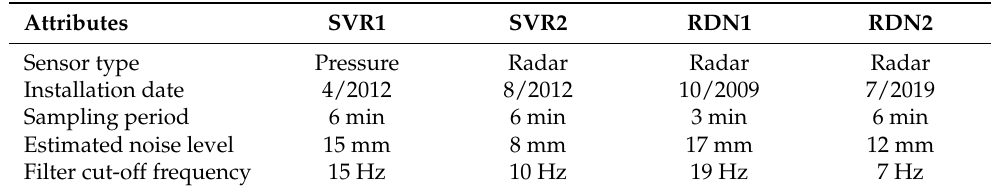
Table 2. Tide gauge characteristics and estimated